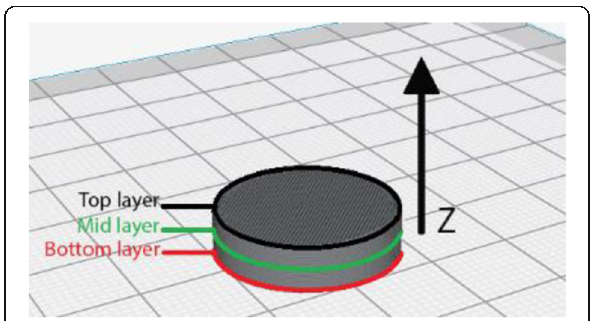
Fig. 1 Layer scheme: red line refers to bottom layer in contact with the building platform, the green line refers to the middle layer at the centre of the sample, the grey line refers to the top surface